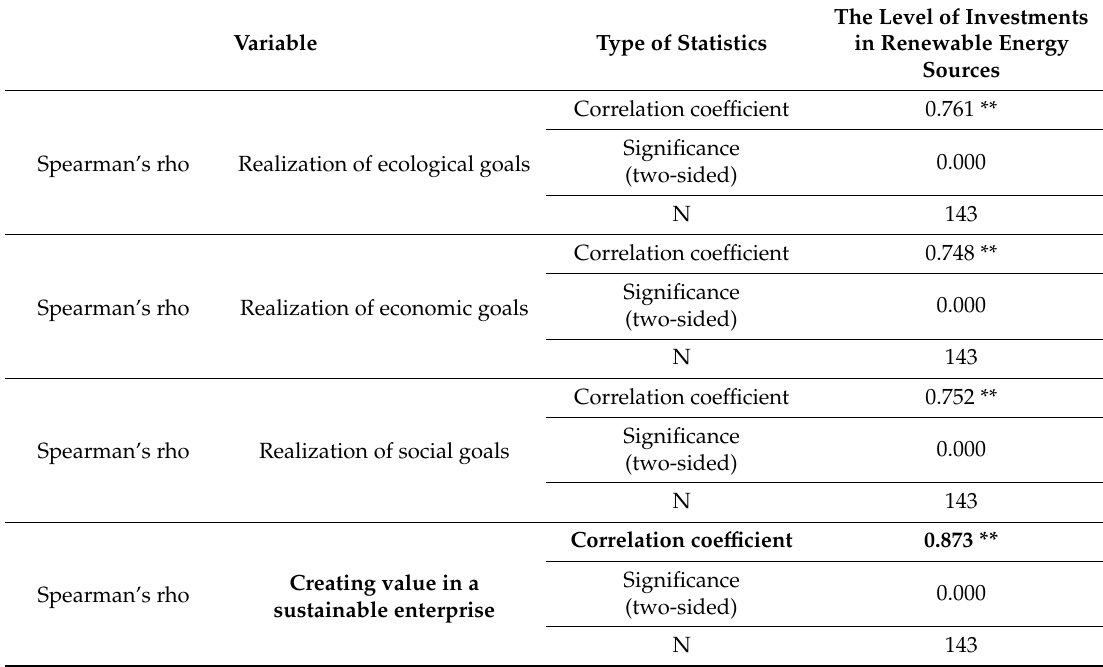
Table 5. Correlation between the level of investments in renewable energy sources and creating value in a sustainable